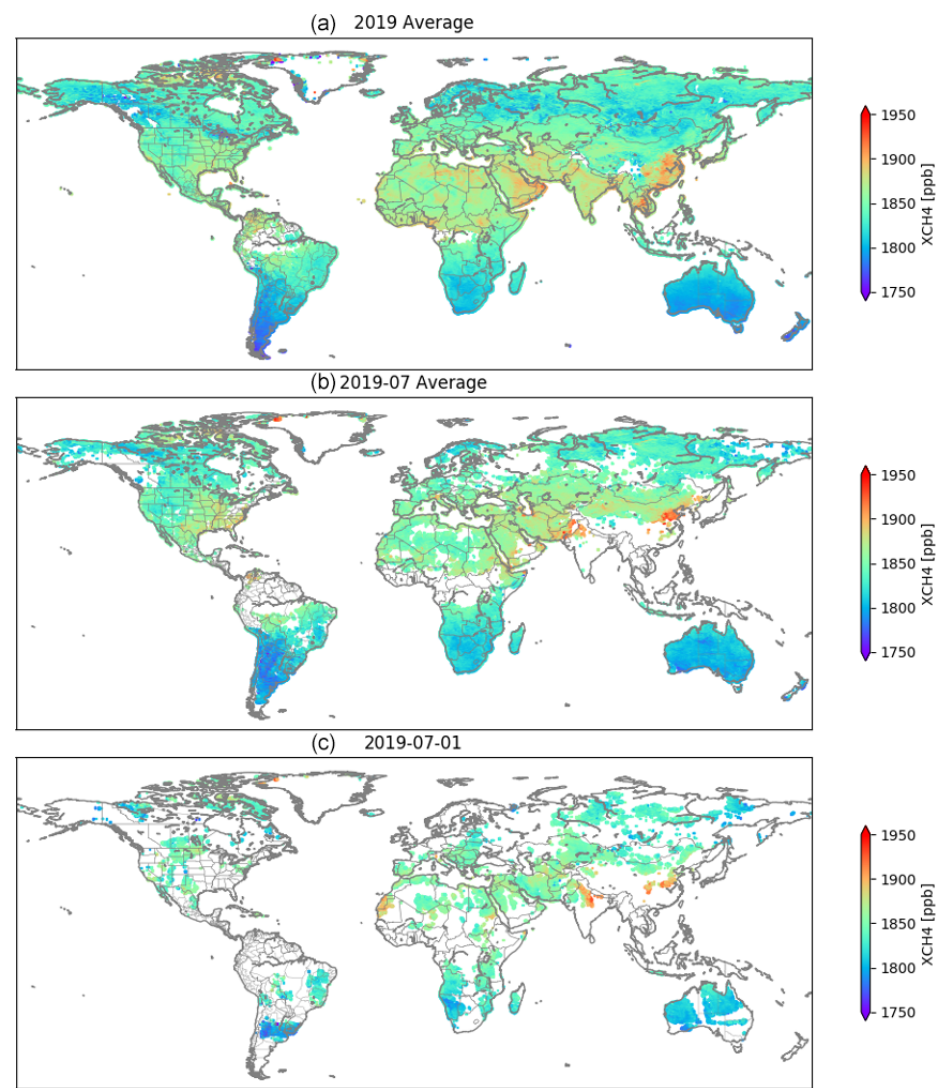
Figure 1. Global average TROPOMI XCH 4 column-averaged dry-air mixing ratios for the full year 2019, July 2019 and 1 July 2019 ( a – c